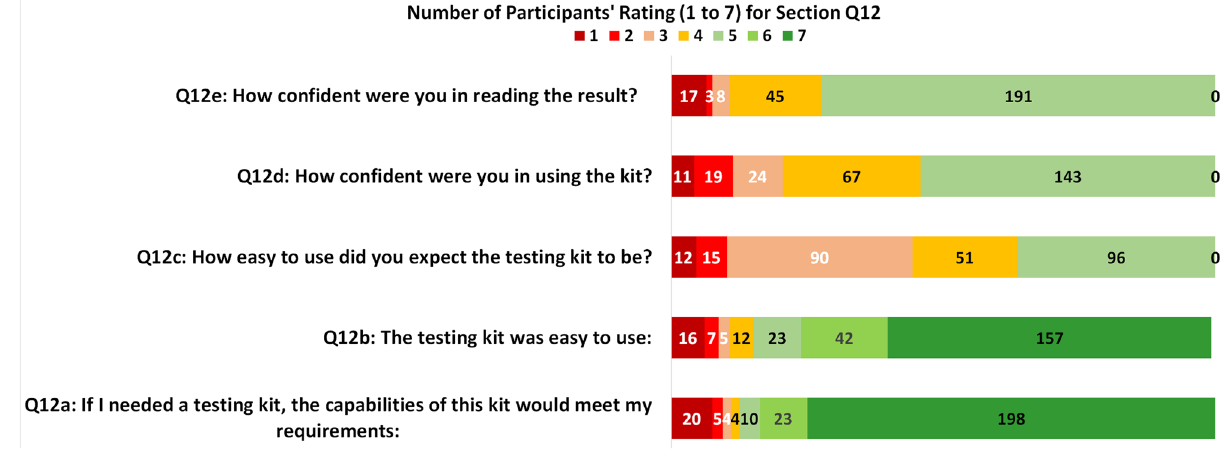
Figure 10. The counts for the 7-point Likert rating scores for question section Q12 (which helps to assess the comfort and acceptability).